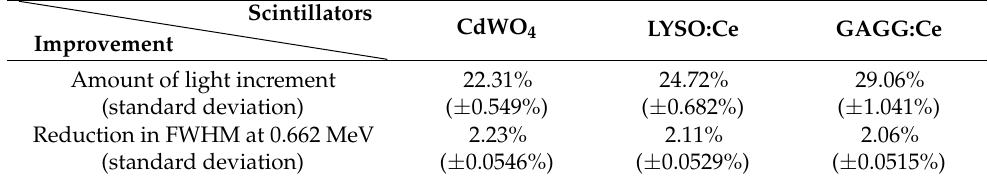
Figure 7. Gamma-ray energy spectra of the 137 Cs radioisotope for three types of inorganic scintillators ( a ) GAGG:Ce, ( b ) LYSO:Ce, and ( c ) CdWO 4 . Table 3. Improvement in the total amount of scintillating light increments and FWHMs reductions in energy spectra of the 137 Cs source according to inorganic scintillators.